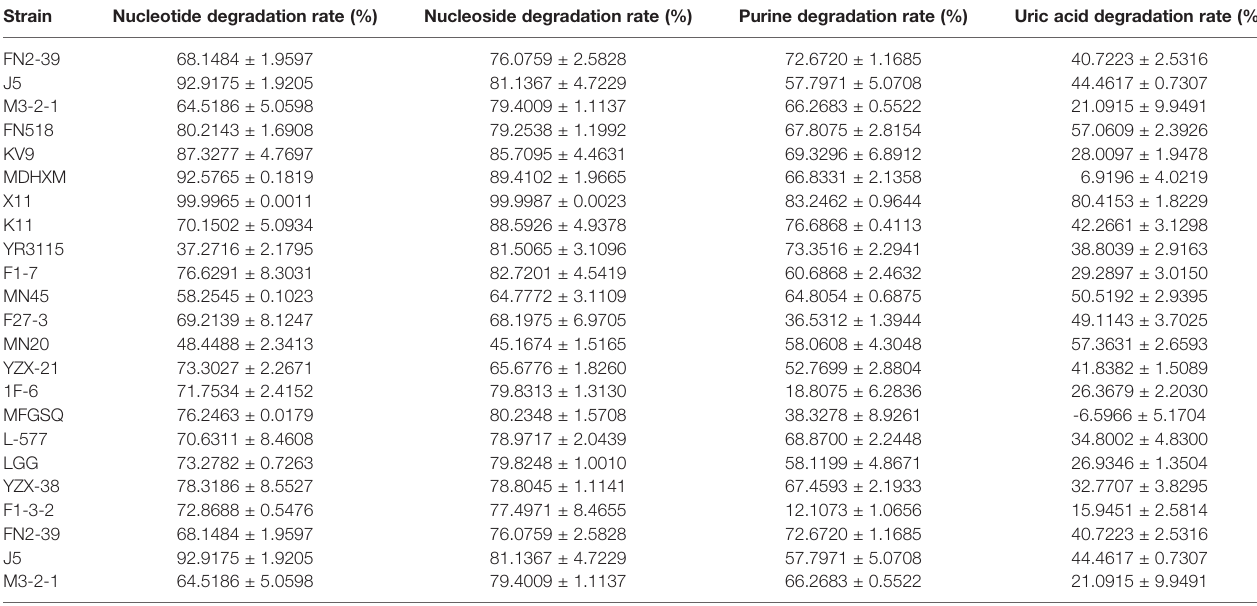
TABLE 2 | Quantitative determination of UA-lowering activity of the strains. Strain